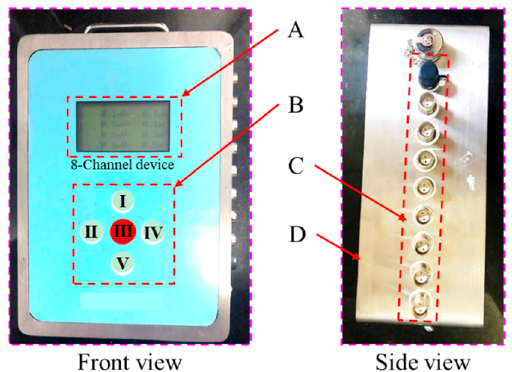
Figure 1. Physical photograph of the EP monitoring host for mining. I—project; II—subtraction; III—power Supply; IV-addition; V-choice; A—data display screen; B—operation panel; C—multichannel interface; D—explosion-proof enclosure.